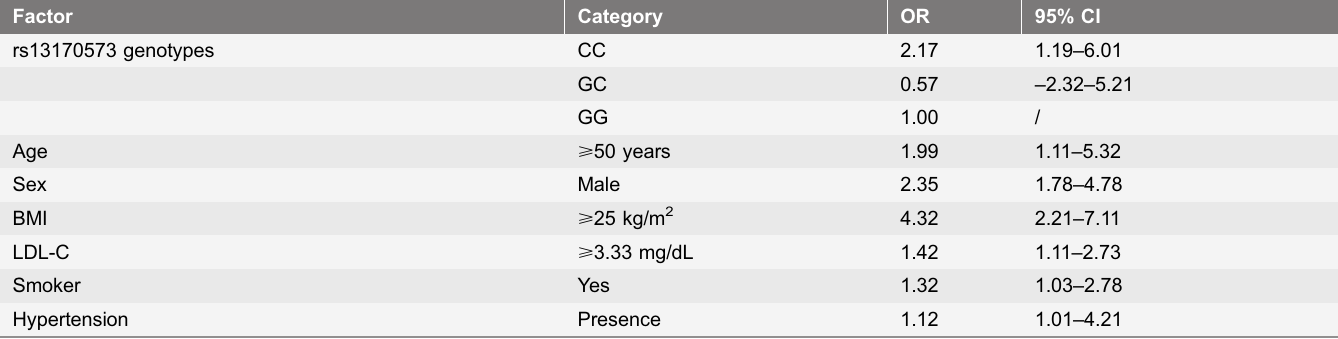
Table 4. Factors associated with OSA in our multivariate